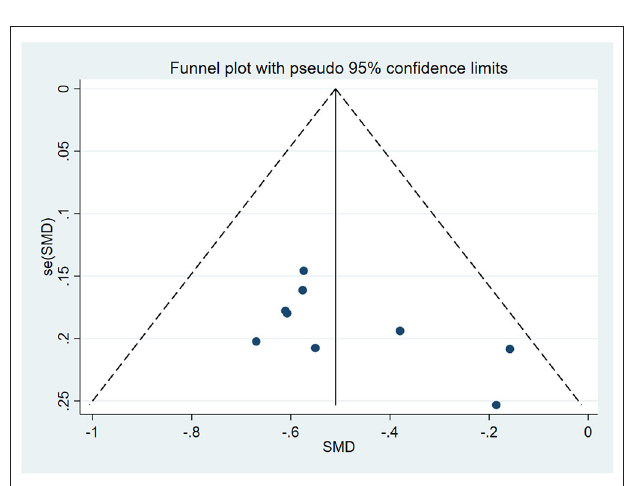
FIGURE 5 | Funnel plot of Association between vitamin D level and